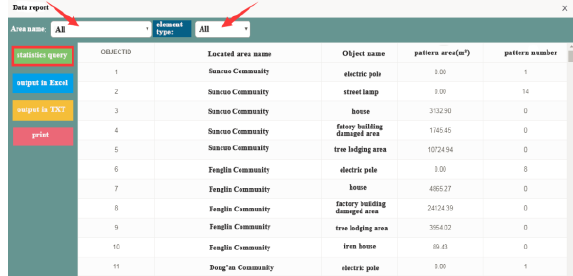
Figure 9. The data report function module of the all affected